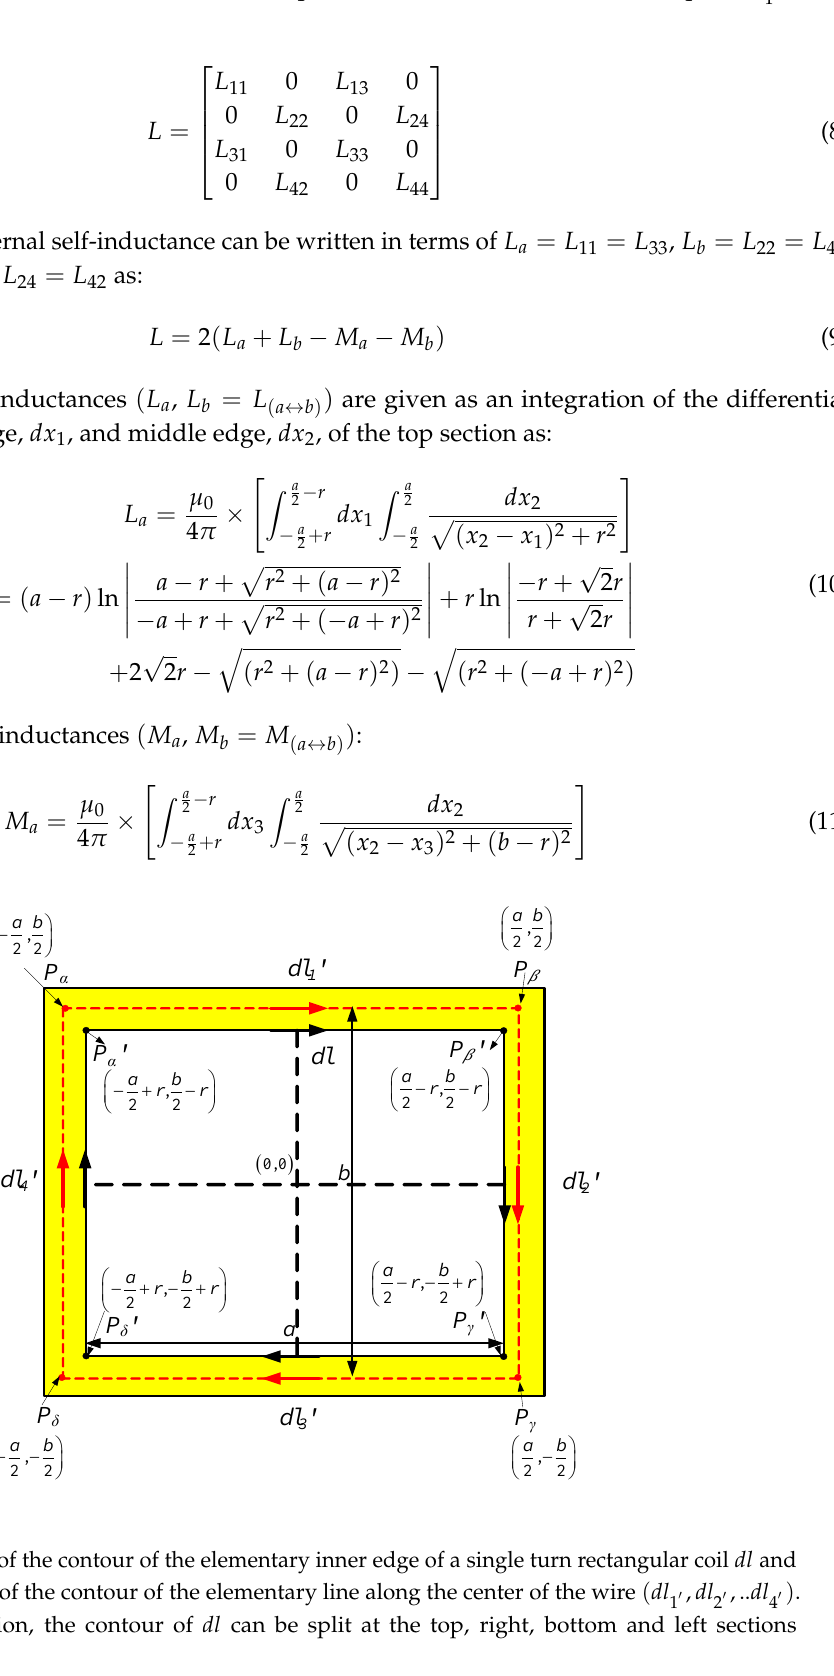
) . , dl ,.. dl 1 (cid:48) 2 (cid:48) 4 (cid:48)